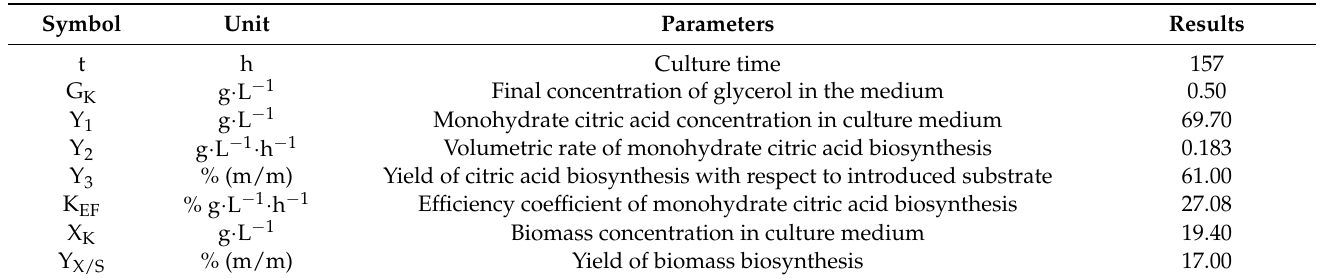
Table 2. Kinetic parameters of citric acid biosynthesis by Aspergillus niger PD–66 in optimized medium containing crude glycerol as a carbon